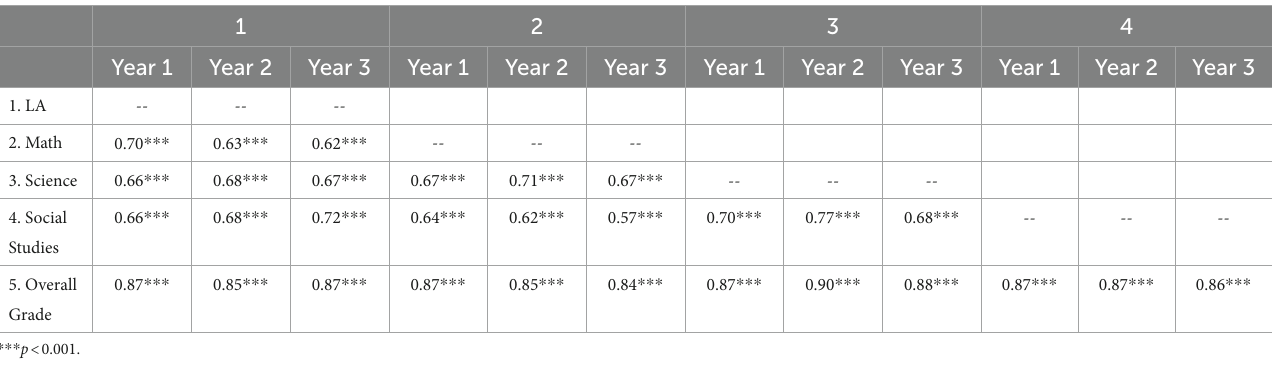
TABLE 5 Pearson’s correlations among academic achievement